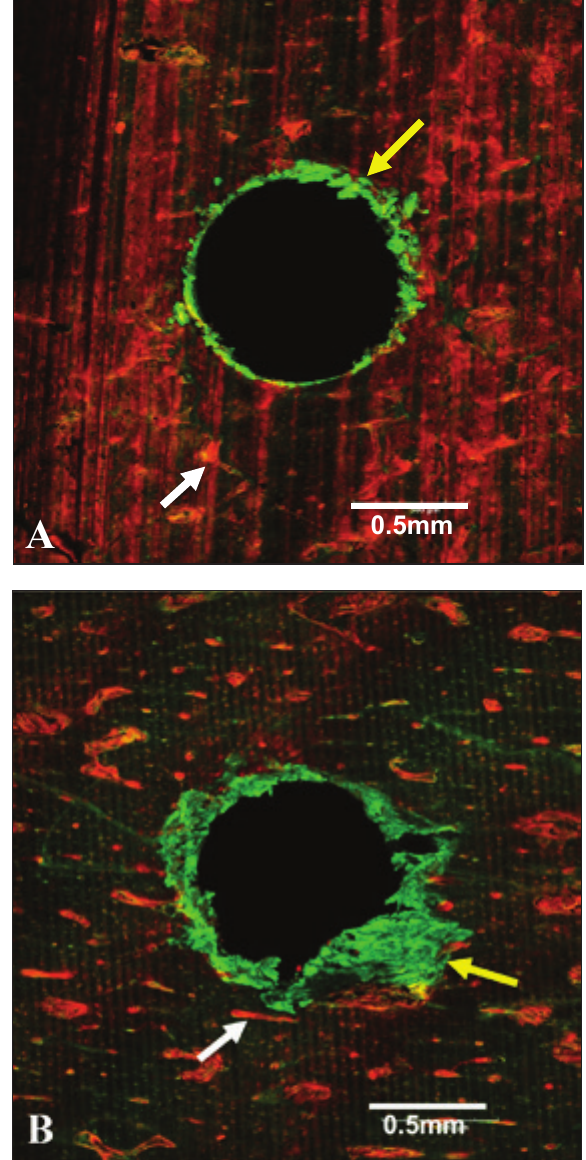
Figure 1. Laser confocal microscopy images depicting the entry (A) and exit (B) surfaces of a 1.5 mm width bone block specimen. The orange flecks (white arrow) represent the surface preparation damage while the green stain (yellow arrow) highlights the damage caused by pilot hole preparation.